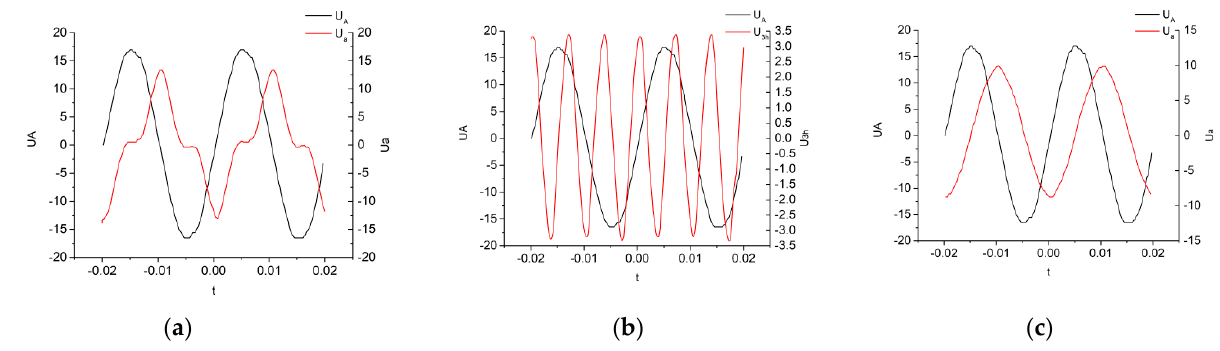
Figure 13. Magnetic-flux-induced voltage test waveform.( a ) When there is A zero-sequence flux path ,phase flux induced voltage U A of column A and flux induced voltage U a of the frame a. ( b ) When there is a zero-sequence flux path ,phase flux induced voltage U A of column A and three phase zero sequence flux induced voltage U 3h. ( c ) When the zero-sequence flux path is not provided, phase flux induced voltage U A of column A and flux induced voltage U a of the frame a. 2. Table 3. Experimental data with and without zero-sequence pathways.